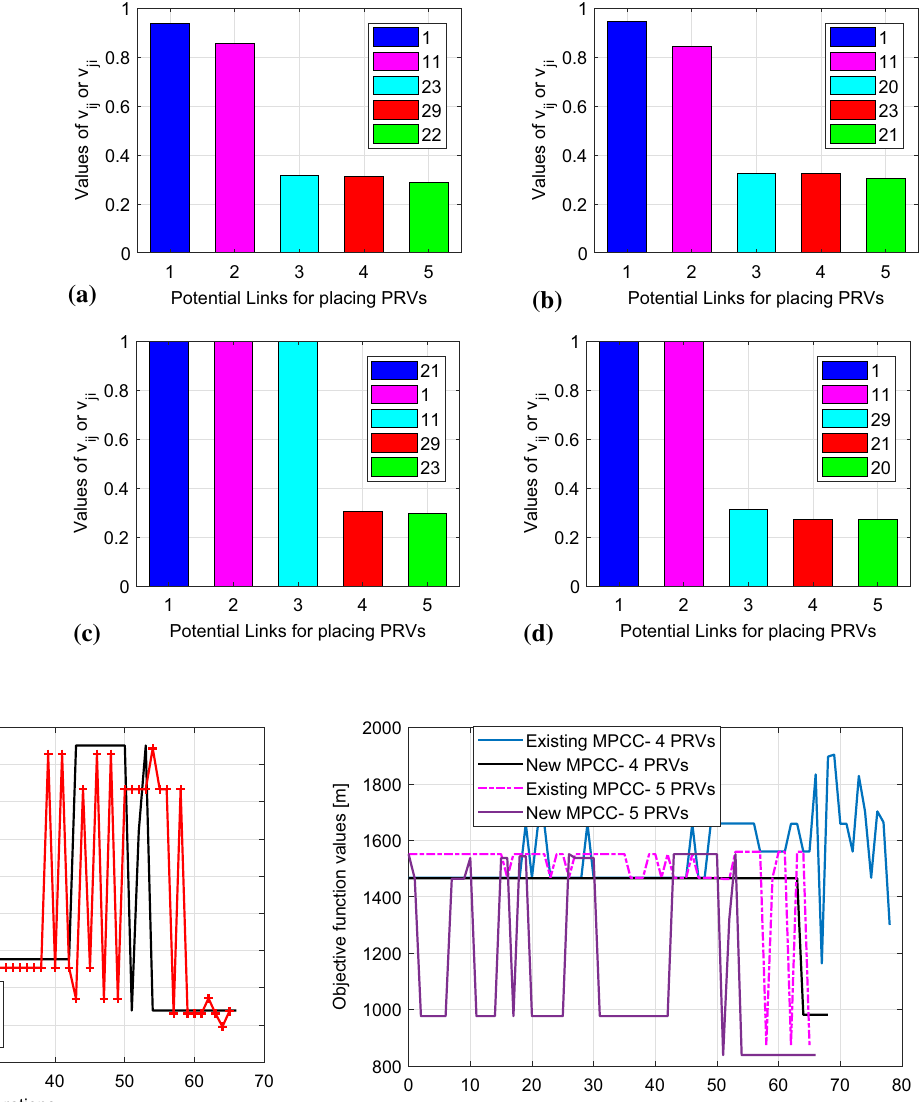
Fig. 3 Potential links for the